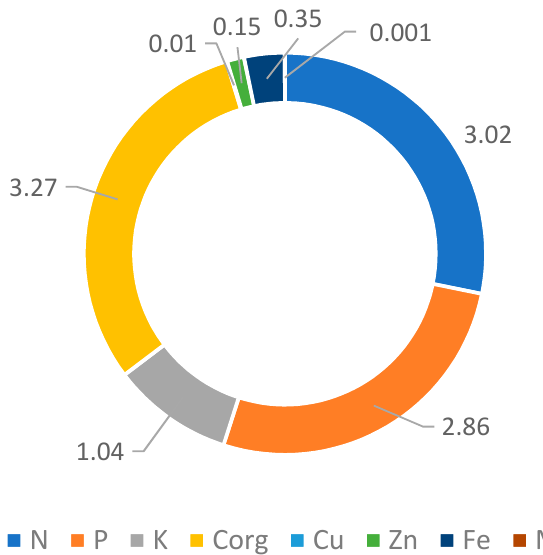
Figure 4. Average value of solid digestate according to the different elements, EUR t − 1 .